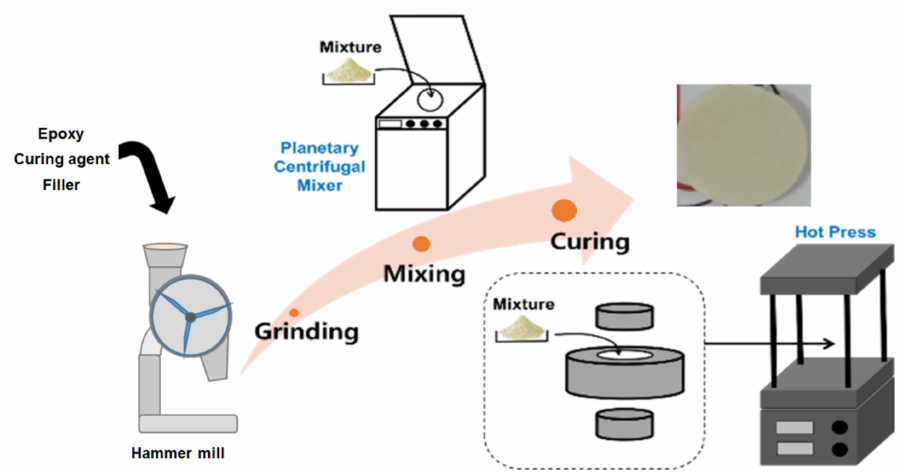
Figure 12. Manufacturing process for thermally conductive composites using liquid crystalline epoxies.